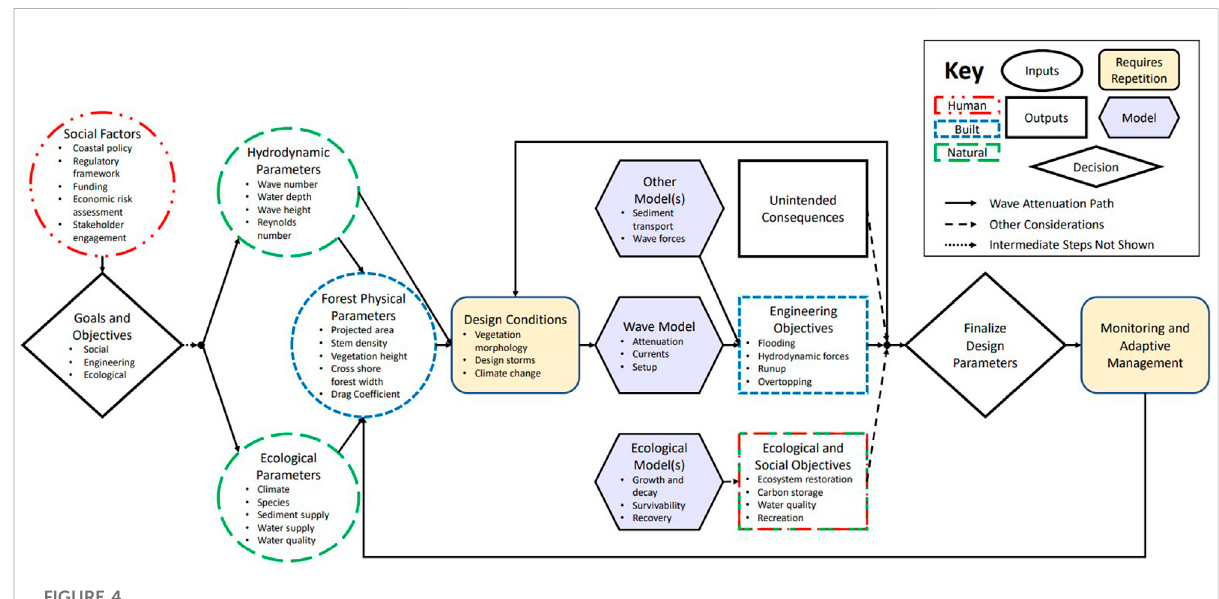
FIGURE 4 Expanded framework for NNBF describing objectives, variables affecting system performance, models for assessing performance, and engineering, ecological, social, and unintended